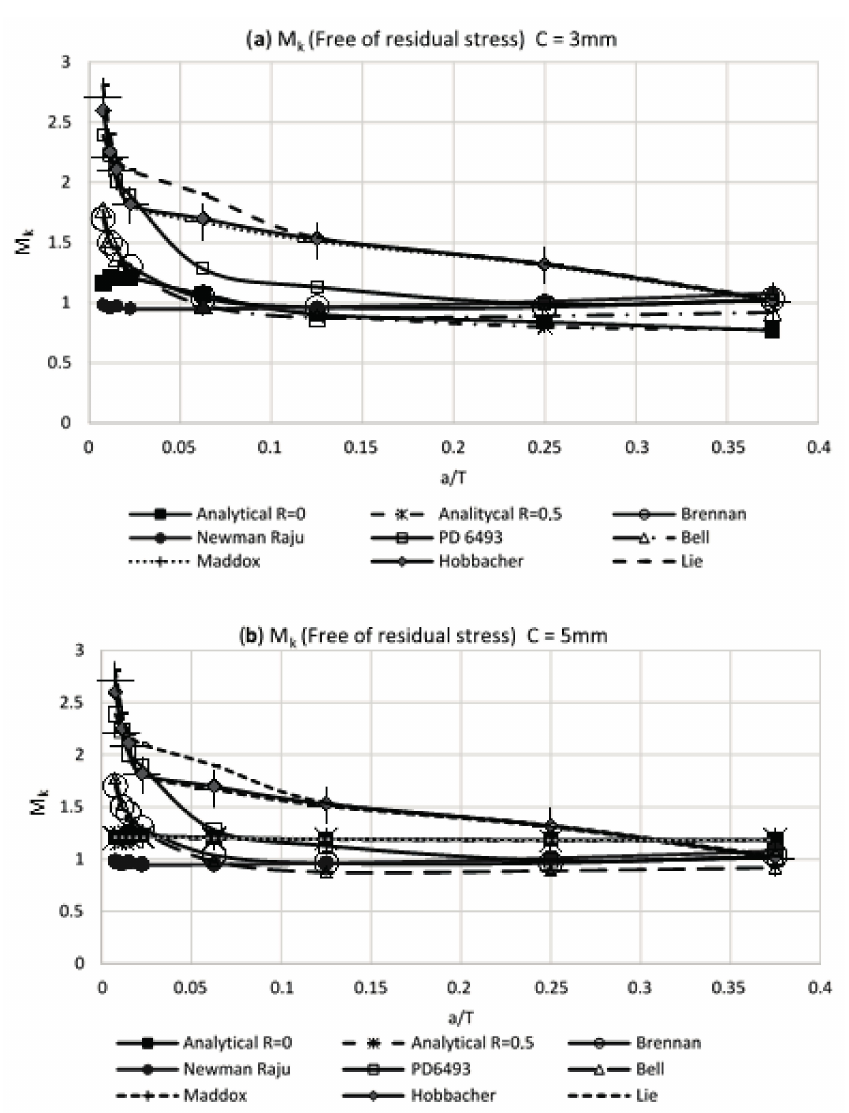
Figure 9. Weld magnification factor M k without residual stress vs. results of other researchers: ( a ) weld size of 3 mm and ( b ) weld size of 5